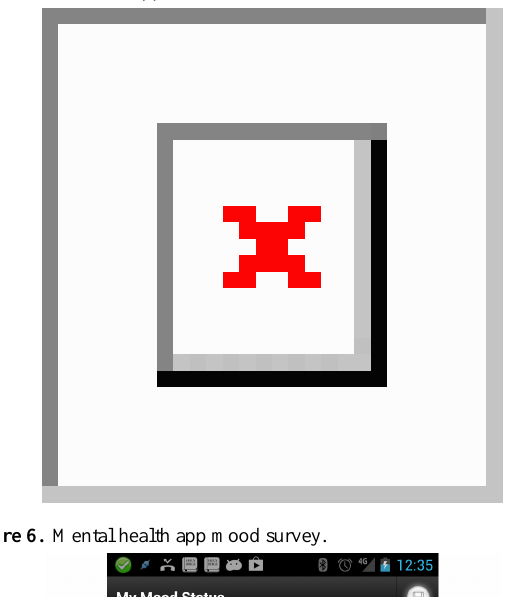
Figure 6. Mental health app mood